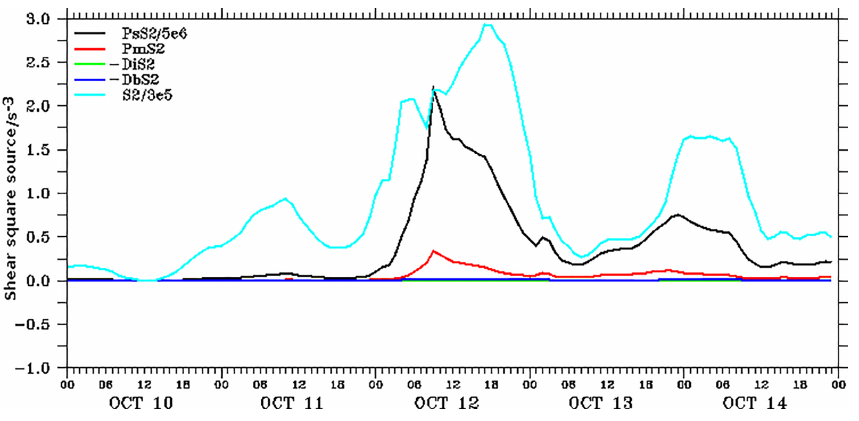
Figure 11. The model-simulated bulk properties at the selected point location. The vertical shear square axis is multiplied by a factor of 10 − 6 . The magnitude of bulk shear squared S 2 (cyan color), surface wind stress P s S 2 (black color), barotropic effect P m S 2 (red color), bottom stress – D b S 2 (blue color), and interfacial friction – D i S 2 (green color) are shown for the duration of the